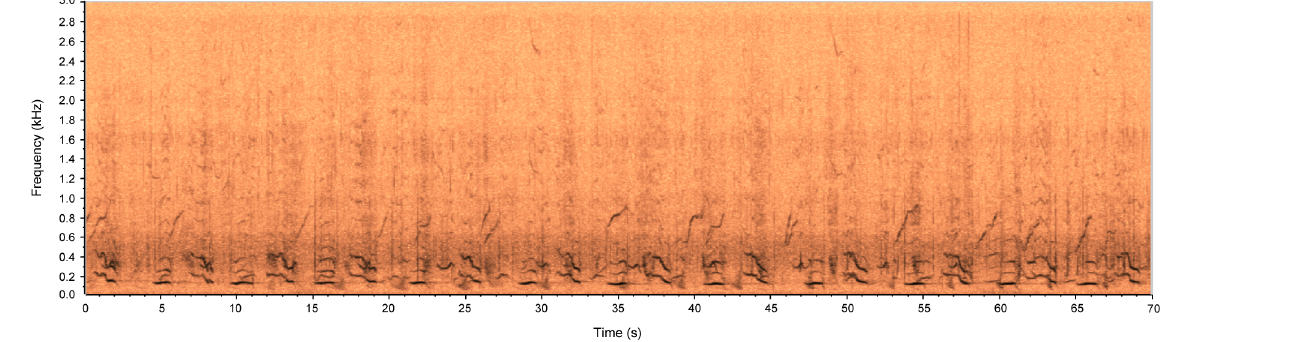
Fig 10. Spectrogram of Humpback whale vocalizations registered in the seaside of the city of Ilhéus, BA, Brazil.